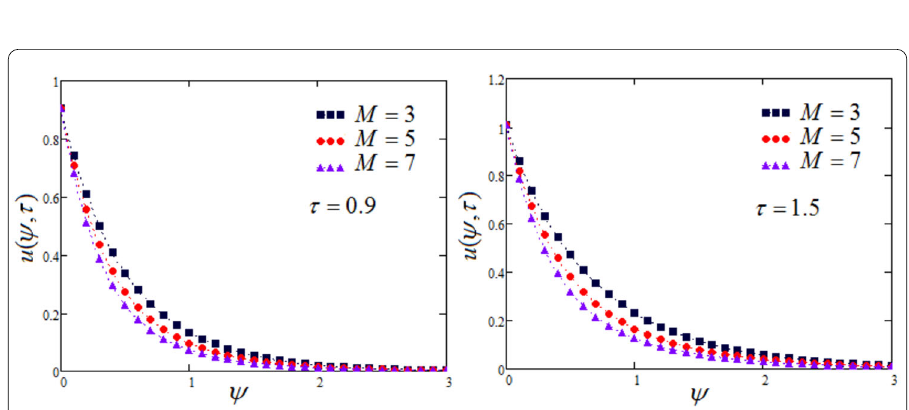
Figure 7 Velocity profiles of a Maxwell fluid for various values of M at two different times